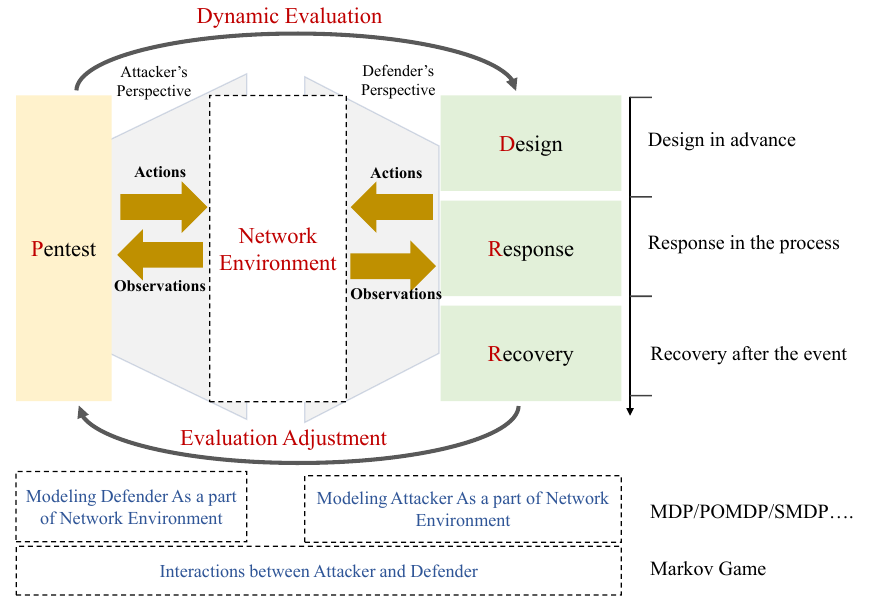
Figure 4. The PDRR